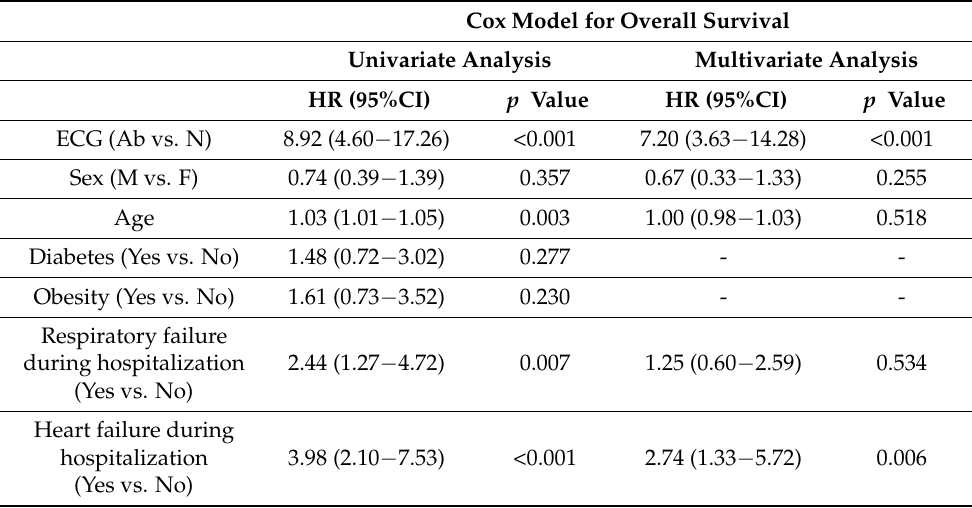
Figure 1. Kaplan–Meier curve of survival freedom among patients with normal and abnormal ECG. Table 3. Cox model for overall survival. Univariate and multivariate correlation between abnormal ECG tracing, heart failure, and overall survival (OS).